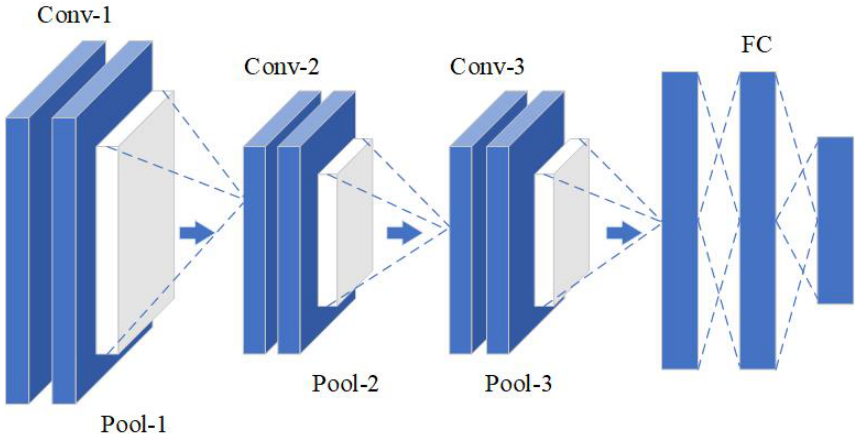
Figure 3. The basic structure of CNN.